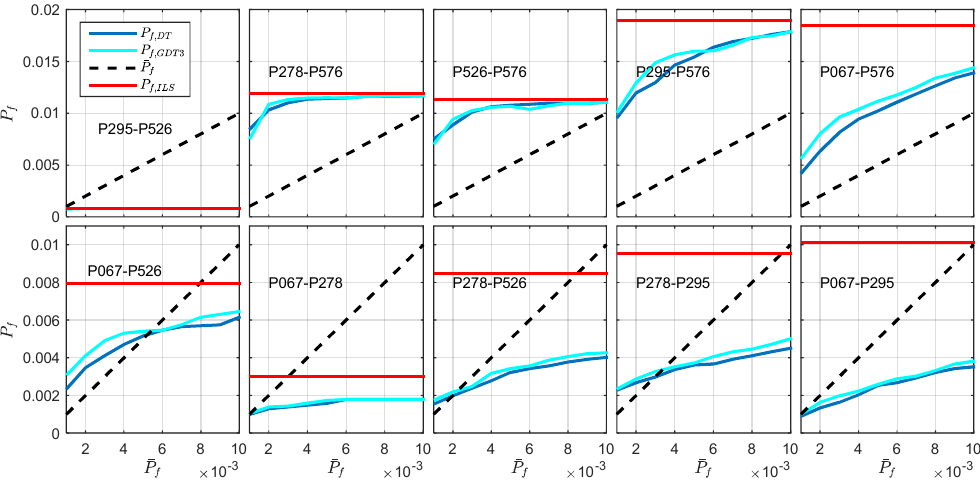
Figure 9. Comparison of the actual failure rate of DT and GDT3 against the failure rate tolerance.